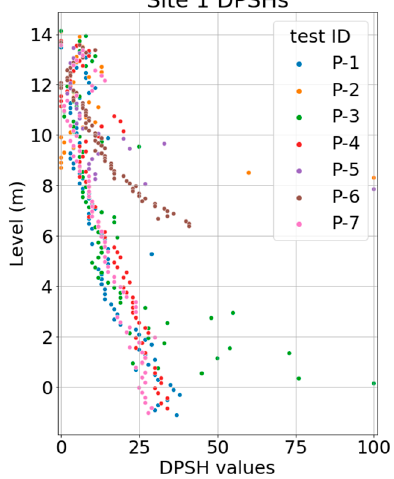
Figure 4. DPSH values for site 1.